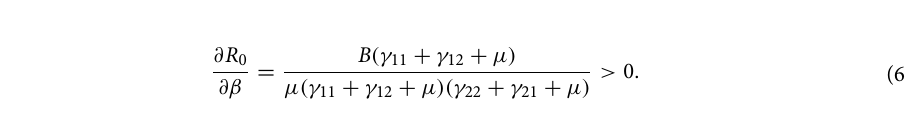
Figure 6. The densities of ( a ) I 1 ( t ) , ( b ) I 2 ( t ) , ( c ) M 2 ( t ) , ( d ) M 3 ( t ) change over time under different control